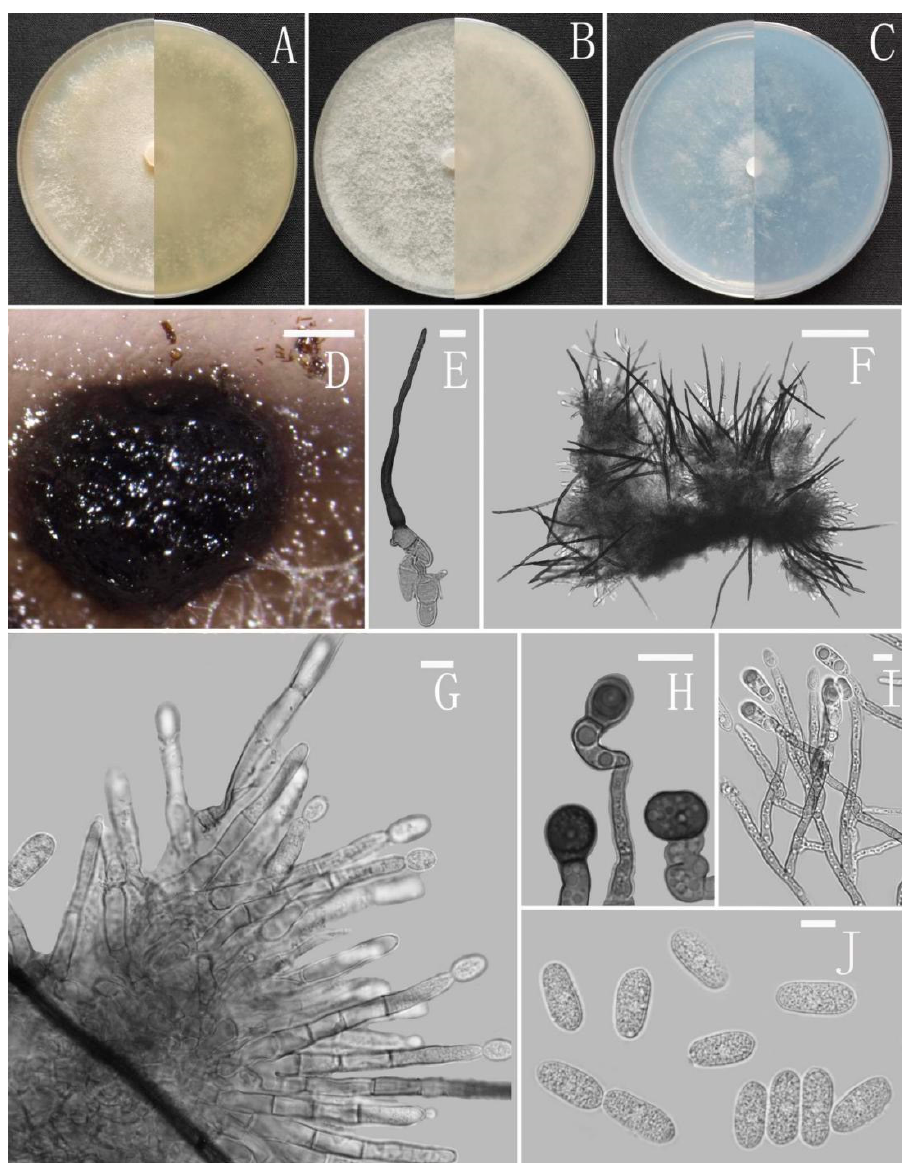
Figure 2. Colletotrichum adenophorae (YMF 1.04952). ( A – C ) Colonies on media above and below after 7 days at 25 °C (( A ) MEA; ( B ) PDA; ( C ) SNA). ( D ) Conidiomata. ( E , F ) Setae. ( G ) Conidiophores and Conidia. ( H ) Appressoria. ( I ) Conidiophores. ( J ) Conidia. Scale bars: ( D ) = 100 μ m, ( E ) = 10 μ m, ( F ) = 50 μ m, ( G – J ) = 10 μ m.